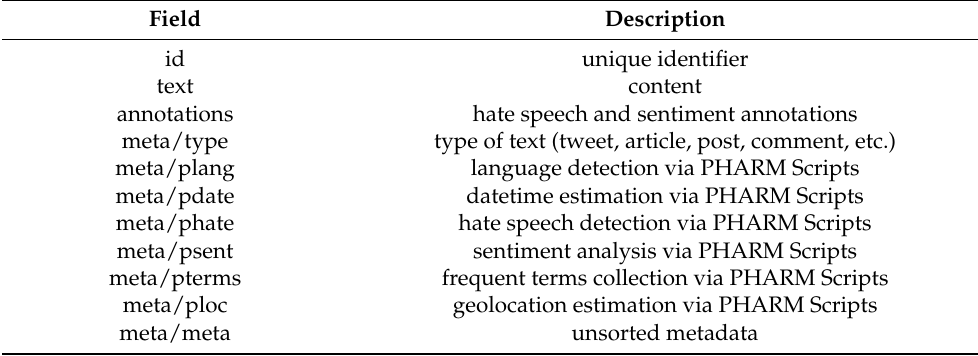
Table 1. The common fields of the specified data format.